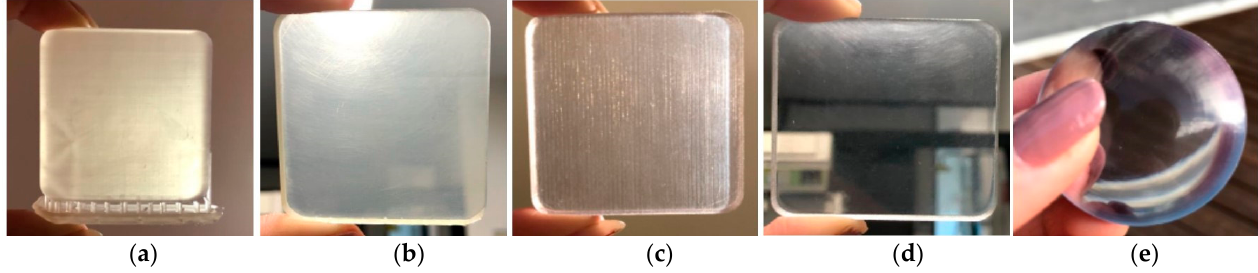
Figure 1. Slabs of t ~1 cm thickness ( a – d ) of transparent Standard Clear (SC) resin without ( a ) and with ( b ) manual polishing and VeroClear (VC) resin without ( c ) and with ( d ) polishing. Slight browning of the SC sample is observed, partially removed by polishing, suggesting surface oxidation occurred during printing. By fluorinating such polymers, this oxidation and subsequent scatter can be largely avoided; alternatively, an inert atmosphere or vacuum can be introduced. A typical convex lens made of C is shown in ( e ) where significant surface Fresnel reflections are seen.